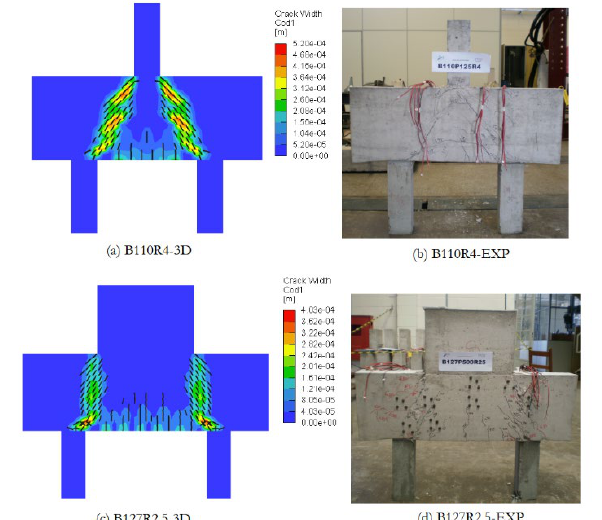
Figure 11. Cracking panoramas of the experimental and three-dimensional numerical models of pile caps on piles of series B110R4 and